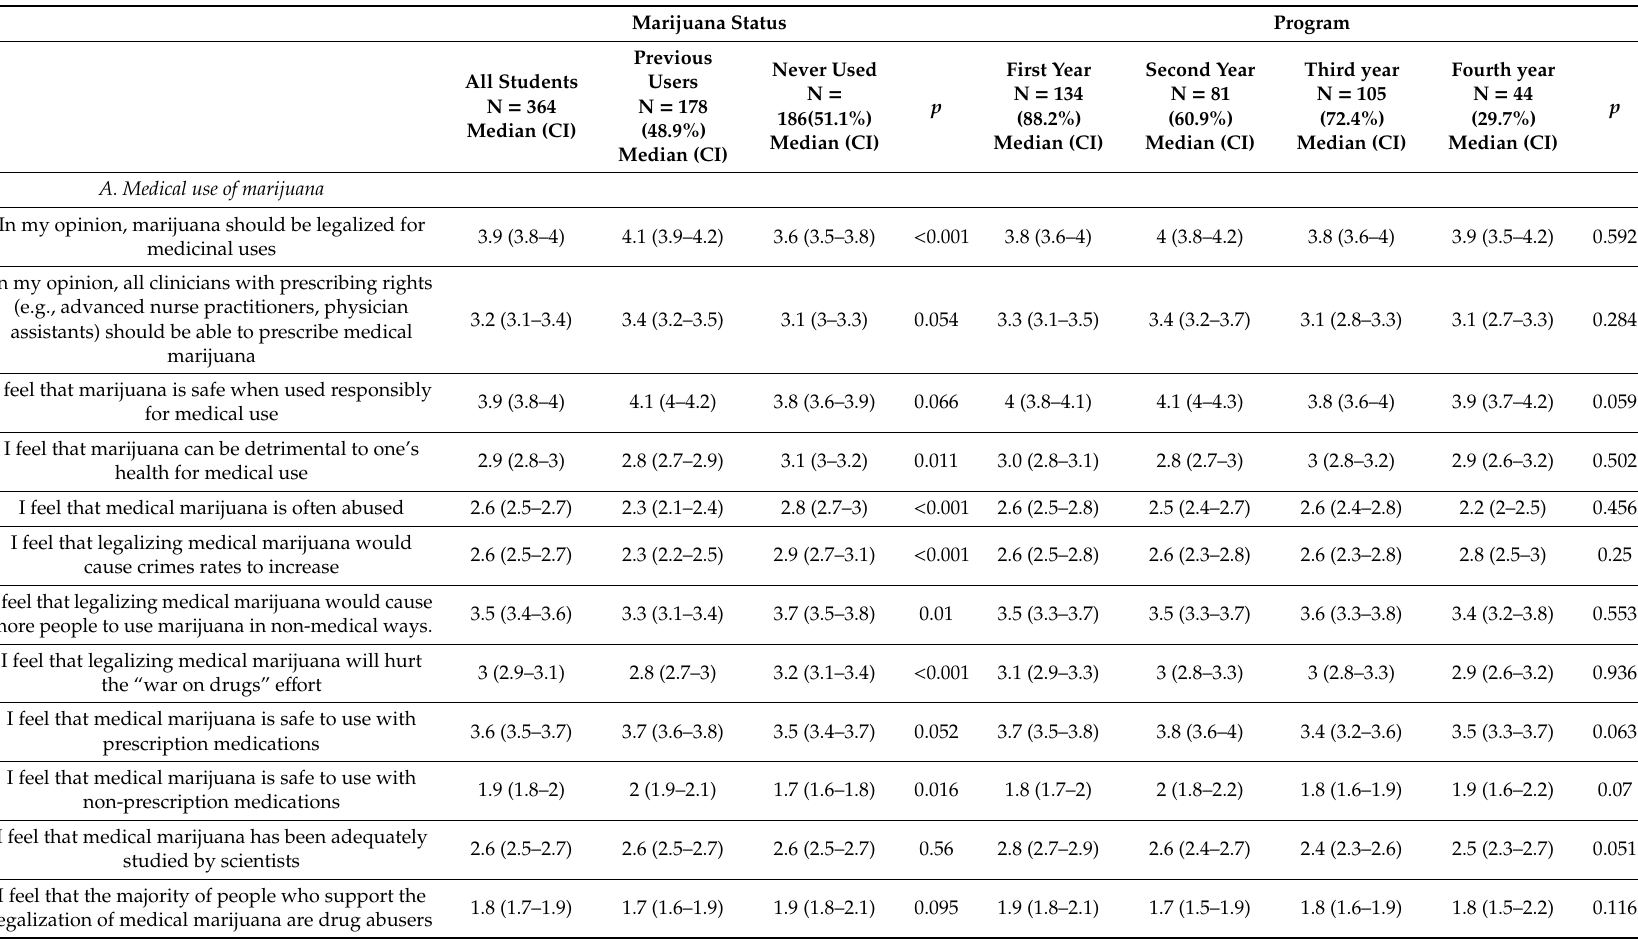
Table 4. Attitudes and opinions about recreational and medical marijuana. Answers were expressed on a five-point Likert scale (1 = strongly disagree to 5 = strongly agree). In order to compare the answers to the questions about opinions and attitudes regarding marijuana-use statuses for the four student years, answers were grouped into three categories (disagree = 1 and 2; neutral = 3; agree = 4 and 5). Statistical significance ( p < 0.05) was determined by ANOVA or Student’s t